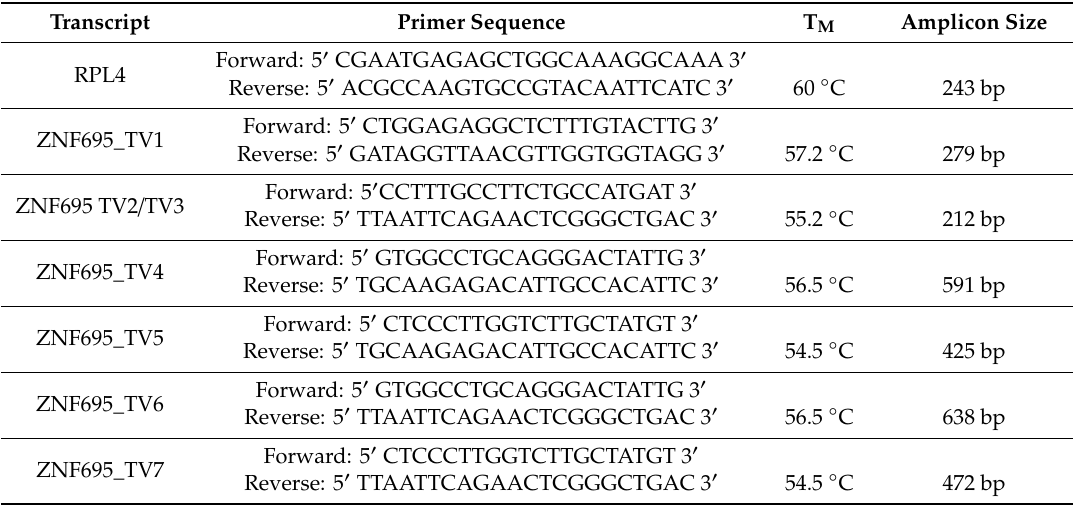
Table 1. Primers designed to amplify the zinc finger 695 alternative splice